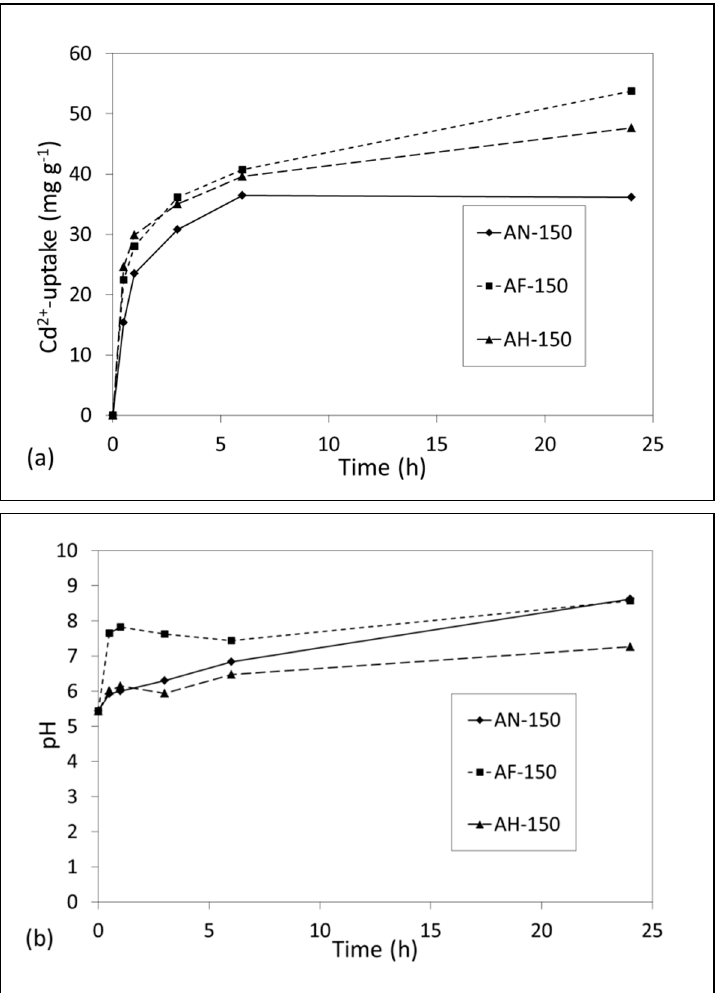
Figure 9. ( a ) Removal of Cd 2+ ions by hydrothermal products AN-150, AF-150 and AH-150 and ( b ) corresponding pH values of the supernatant liquors.